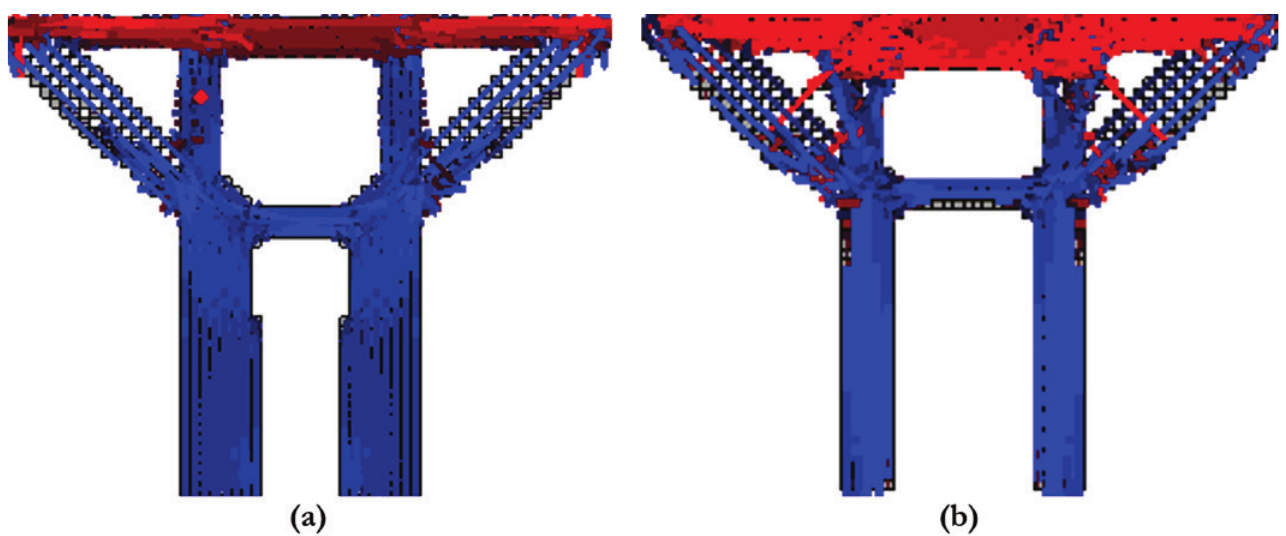
Optimum topologies by ESO and stress distribution required for the element, according to FEM (a) for linear and (b) non-linear